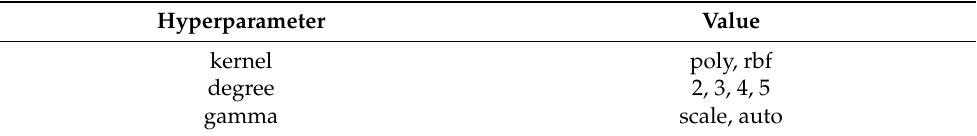
Table 2. Hyperparameters to determine the optimal values for support vector regressor.